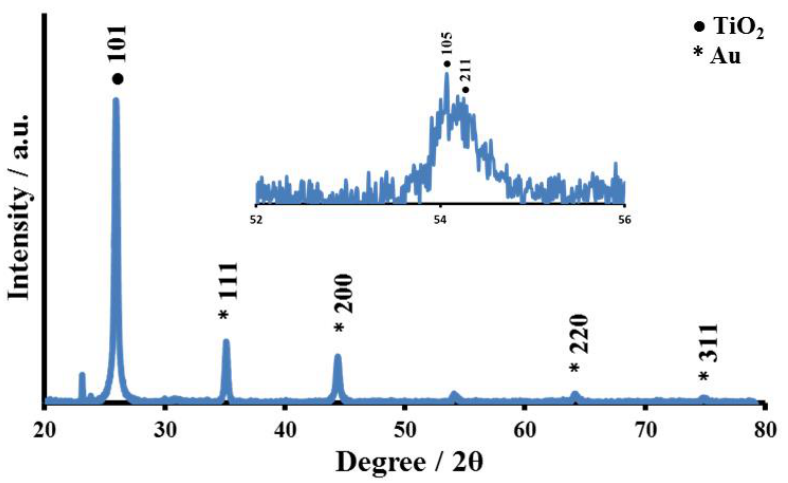
Figure 3. X-ray diffraction pattern for the prepared core – shell Au@TiO 2 material (Au =